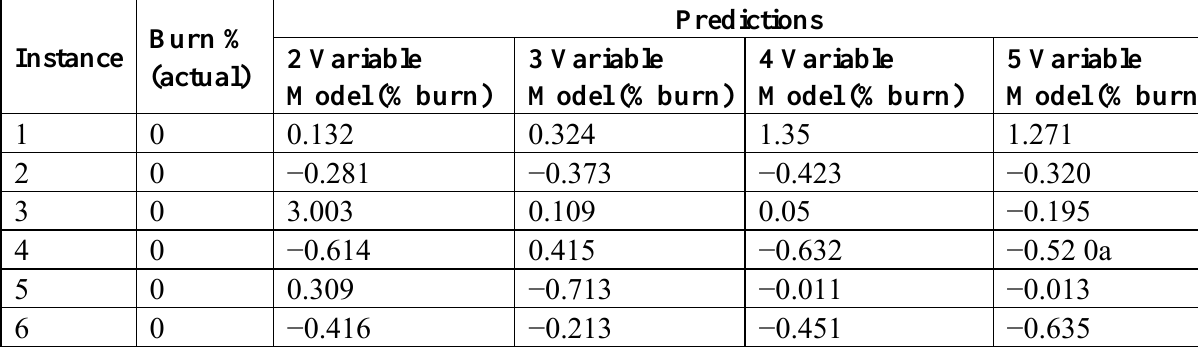
Table 5. Predictions of neural network model (Training on all data)